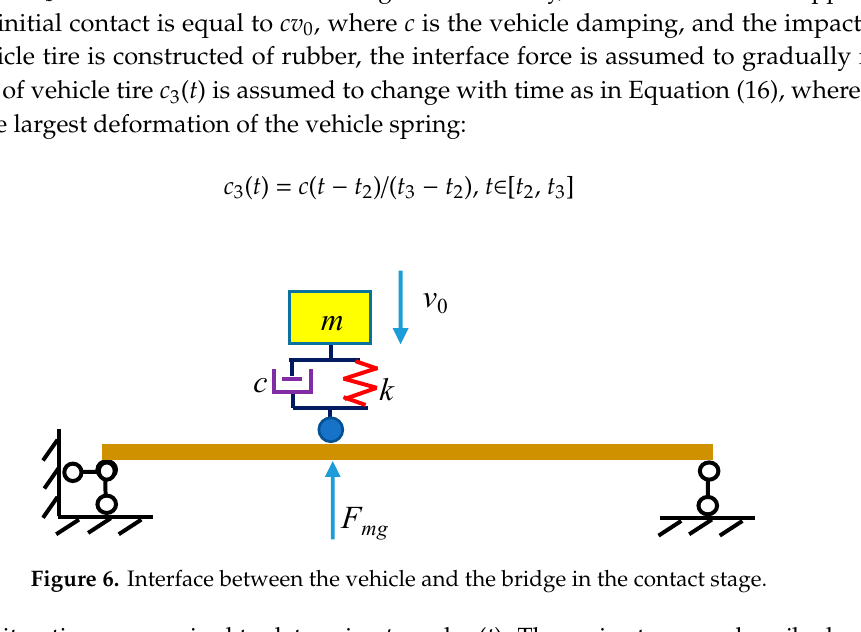
Figure 5. Force analysis in the separation period.